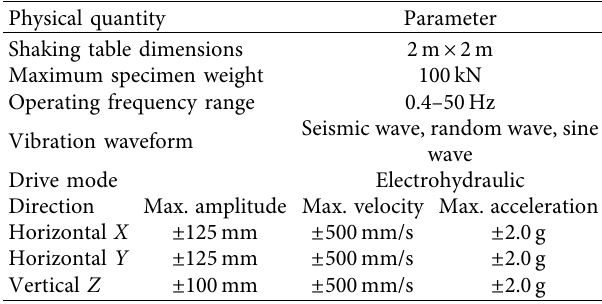
Figure 4: Experiment mode. Table 2: Specifications of the earthquake simulation system.